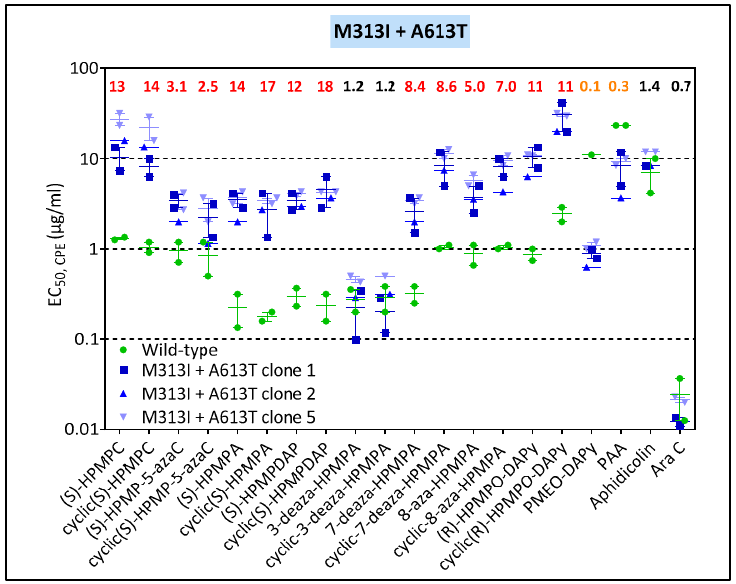
Figure 4. ( A ) Drug-susceptibility profile of selected VV2 viral clones bearing the M313I + R577G + A684V w/o the A677T change. All clones harbored the W8C substitution, which is expected to be linked to a natural occurring genetic polymorphism since it maps to the beginning of the N-terminal structural domain where drug-resistance mutations have not been described. Drug-resistance properties of the two viral clones were determined using a CPE reduction assay with HEL fibroblasts. ( B ) Drug-susceptibility profile of selected VV8 HPMPO-DAPy-R viral clones to evaluate the impact of the M313I, R407C, L511F, and A613T DNA polymerase substitutions. The source of the viral clones was as follows: M313I (VV8 HPMPO-DAPy #4), M313I + A613T (VV8 HPMPO-DAPy #9), and M313I + A613T+ A684V (VV8 HPMPO-DAPy-R #36). Drug-resistance properties of the different types of viral clones were determined using a CPE reduction assay with HEL fibroblasts. The effects of different drugs on viruses encoding the indicated mutations were determined by calculating the EC 50 values for the parental wild-type strain and clones bearing the specific mutations. At least two independent experiments were performed for each test compound. Horizontal lines for each drug and mutant viral clones indicate the mean values ± standard deviation. The fold resistance (ratio of the EC 50 for the mutant viruses to the EC 50 for the corresponding wild-type virus is marked at the top of the graph. VACV viral clones showing a ≥ 2-fold increase (red, bold) were considered drug resistant (R) and those with a ≤ 0.5-fold decrease (orange, bold) drug hypersensitive (hs). The known drug-resistant mutations A314V and A684V were found together with